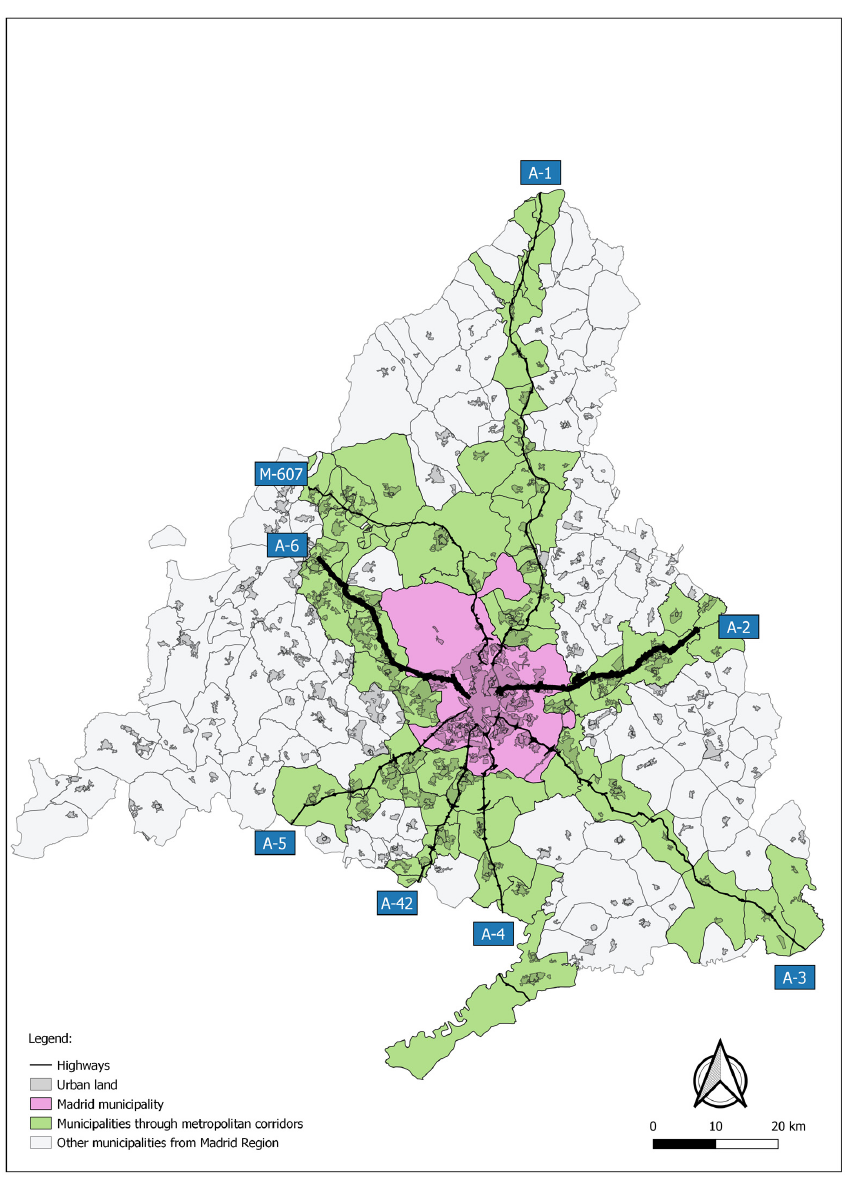
Figure 1. Madrid Region, administrative boundaries (municipalities), radial motorways, and associated corridors. (QGIS Software).